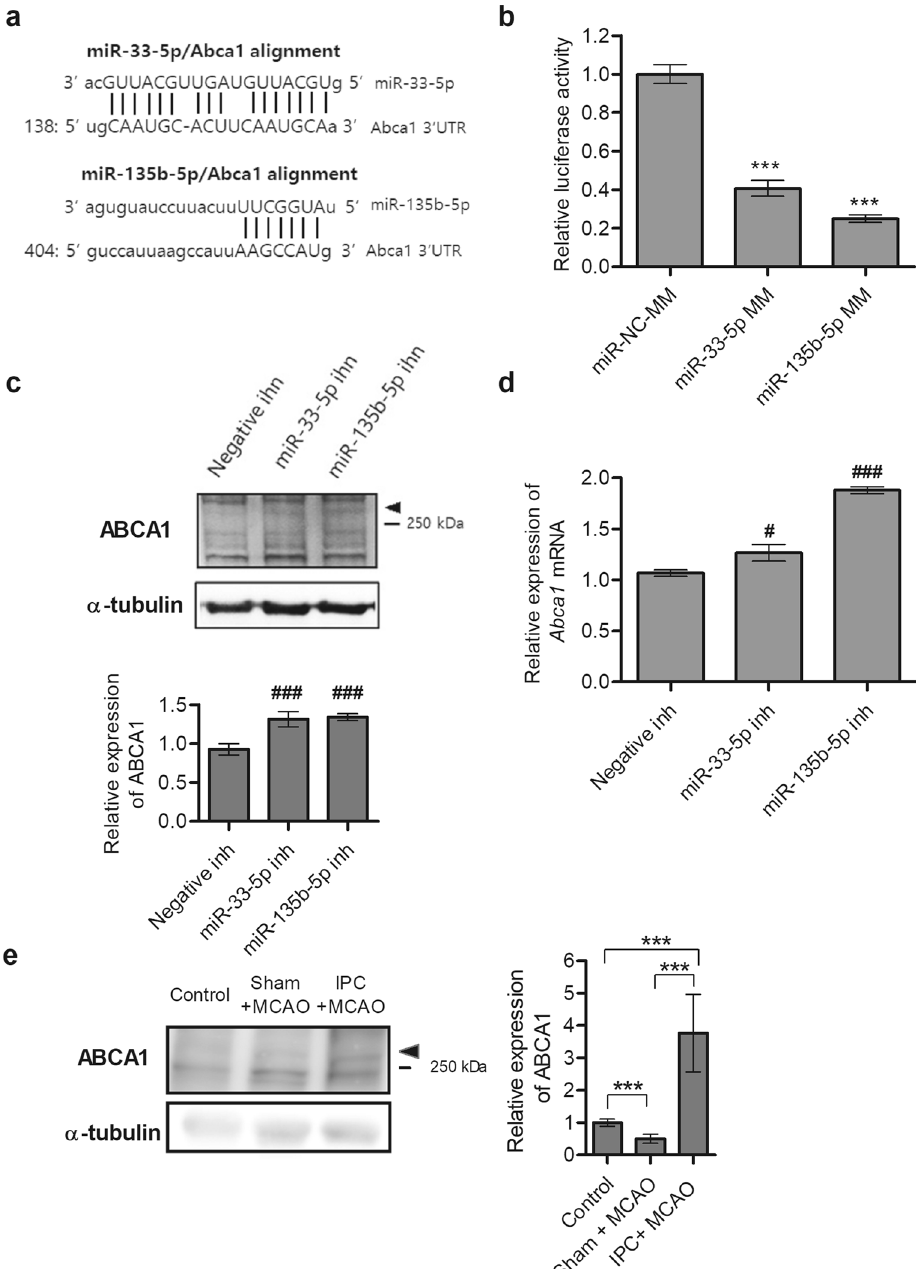
Figure 4. Identification of Abca1 mRNA as a target for miR-33-5p and miR-135b-5p. ( a ) The 3’-UTR of ATP-binding cassette subfamily A member1 ( Abca1 ) mRNA contains putative binding regions for miR-33-5p and miR-135b-5p. ( b ) The relative luciferase activity of an Abca1 3 ′ -UTR reporter plasmid was assayed in Neuro-2a cells after transfection with miR-33-5p mimic (MM), miR-135b-5p MM, or miRNA negative-control mimic (miR-NC-MM). ( c ) Neuro-2a cells were transfected with miR-33-5p inhibitor, miR-135b-5p inhibitor, or a relevant negative-control inhibitor. Twenty-four hours after transfection, cells were subjected to 5 h of hypoxia and 1 h of reperfusion. ABCA1 protein expression was then assessed using Western- blot analysis. Representative results are illustrated, and values from densitometric analyses are shown after normalization to α-tubulin from the controls. Full-length blots are presented in Supplementary Fig. 2. ( d ) Abca1 mRNA expression was measured by RT-qPCR. Data are represented as mean ± standard deviation from three experiments. Statistical analyses were performed using one-way analysis of variance followed by Dunnett’s multiple comparison test using negative inhibitor as the control (# = p < 0.05, ### = p < 0.001). ( e ) MCAO for 30 min was performed in C57BL/6 mice 24 h after either a sham or IPC operation. After 3 h of reperfusion, the ipsilateral cortex was harvested and ABCA1 protein expression was assessed using Western-blot analysis. Values from densitometric analyses are shown after normalization to α-tubulin values from the controls. Data are mean ± standard deviation (n = 6). Statistical analyses were performed using t -tests (* = p < 0.05, ** = p < 0.01, *** = p < 0.001). Full-length blots are presented in Supplementary Fig. 3. Abbreviations: UTR, untranslated region; miR, micro ribonucleic acid; inh, inhibitor; MCAO, transient middle cerebral artery occlusion; IPC, ischemic